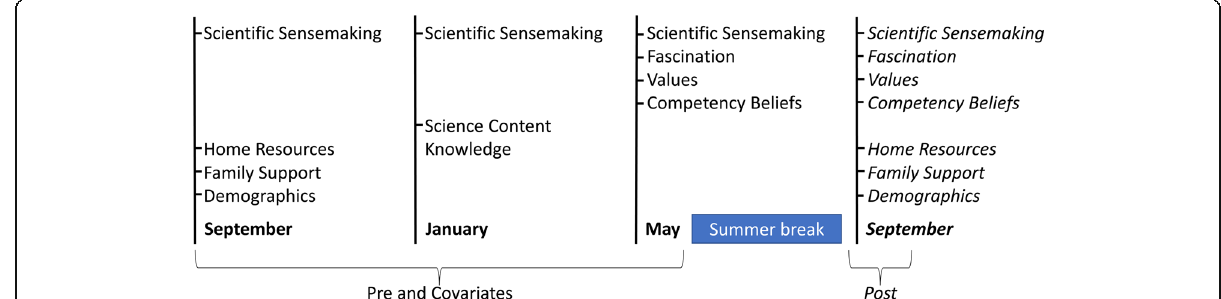
Fig. 1 Timeline of pre and post measure data collection. Italics denote post measures